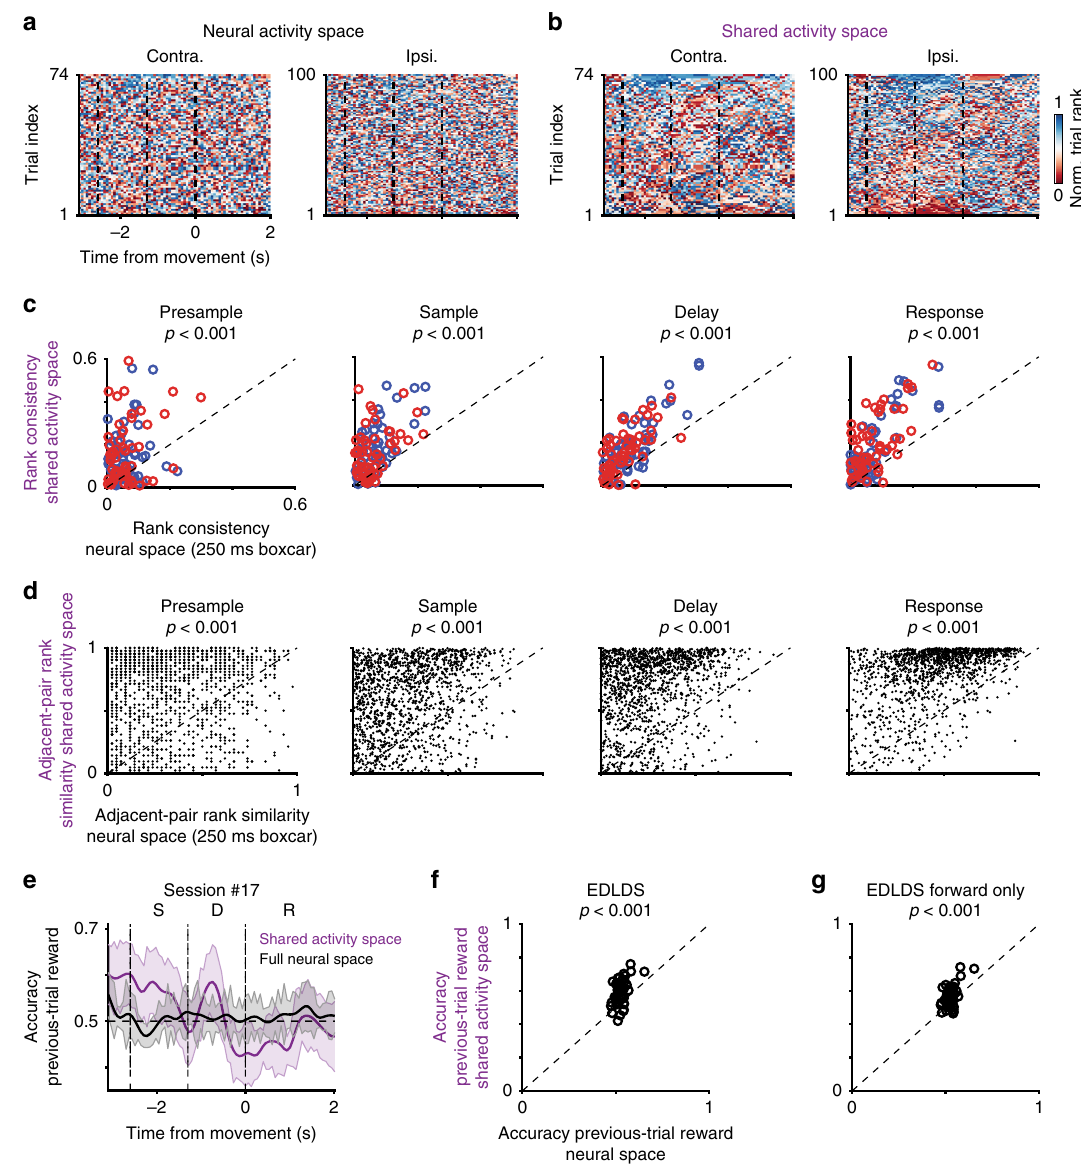
Fig. 5 Long timescale structure of population activity revealed in shared activity space. a Heatmap of relative rank of population activity in full neural space for each trial type (74 contra, 100 ipsi trials). Rank at each time point was normalized to the maximum number of each trial type. b The same plot as a for activity in shared activity space. c Comparison of rank consistency across trials based on the averaged activity within each behavioral epoch in shared activity space ( y -axis) versus full neural space ( x -axis). Blue, contra.; red, ipsi. trials; each circle represents a single session. d Comparison of the rank- dynamics (change of within-epoch rank) consistency between two adjacent trials (1344 pairs across 55 sessions) in shared activity space (y-axis) versus full neural space ( x -axis). e Decoding accuracy whether a previous trial was rewarded for decoders based on shared activity space in purple, for full neural space in black; shaded area, std. across trials. f Scatter of average decoding accuracy over pre-sample period for decoders based on full neural space ( x - axis) or shared activity space ( y -axis). Dash line, diagonal line. g The same convention as in f except comparing to shared activity space based on forward- only EDLDS fi t ( y -axis). All p < .001, sign-rank